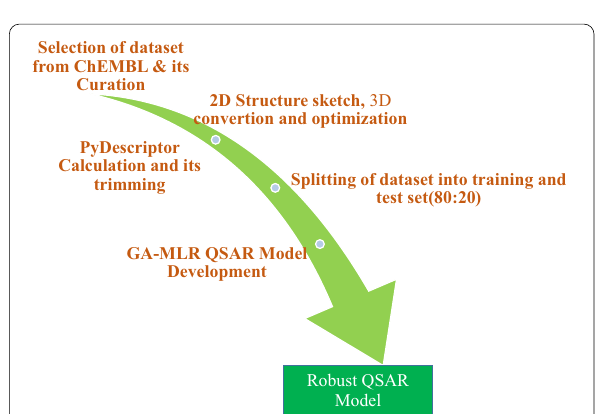
Fig. 2 Depiction of plot drawn between the number of descriptors against coefficient of determination R 2 and leave-one-out coefficient of determination Q 2 to identify the optimum number of descriptors